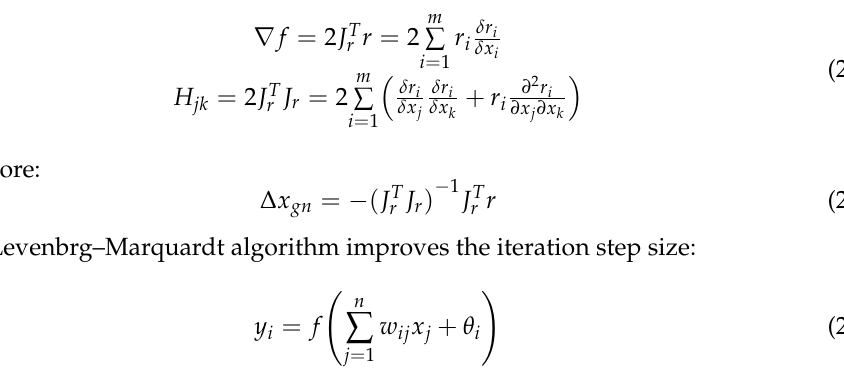
−1 Figure 10. Fault indicators under normal operation load and disturbance. The current waveform of the open-circuit fault of phase a at 0.3 s is shown in Figure 11. The load torque is 30 N·m, and the phase failure of phase a occurs at 0.3 s. The phase a current becomes zero after 0.3 s. Among the remaining four-phase currents, phase b and